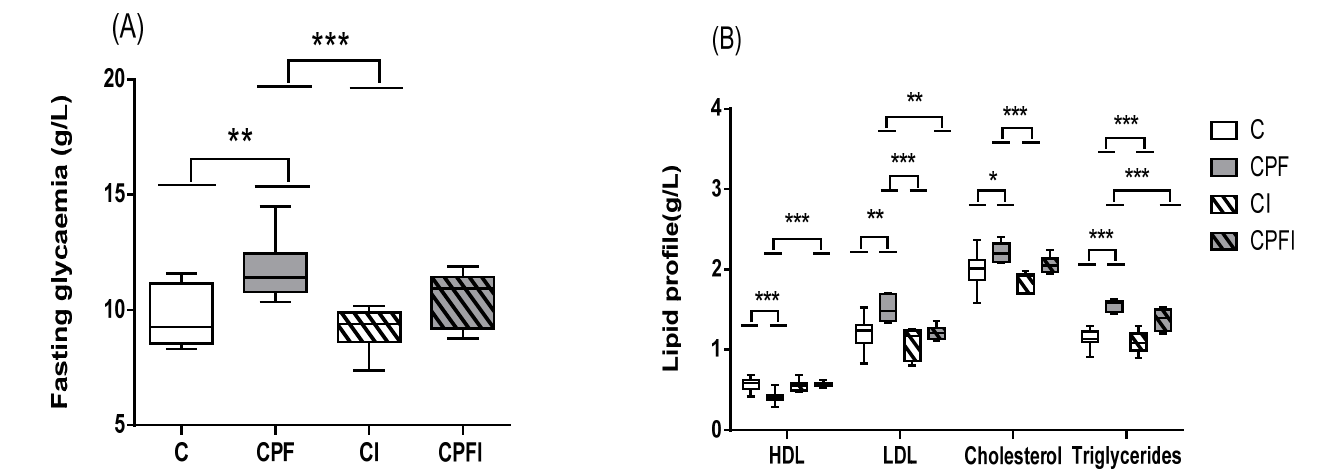
Figure 3. Effects of perigestational exposure to CPF and inulin on blood glucose ( A ) and lipid levels ( B ) in female offspring. Blood glucose, Total cholesterol (TC), plasma triglycerides (TG), high-density lipoproteins (HDL) or low-density lipoproteins (LDL) were measured in plasma. Values are expressed as mean ± SEM ( n = 7–10) using analysis of variance (ANOVA) and Tukey’s test. Significance * p < 0.05; ** p < 0.01, *** p < 0.001. C: Control; CPF: Chlorpyrifos; CI: Control inulin; CPFI: Chlorpyrifos + inulin.